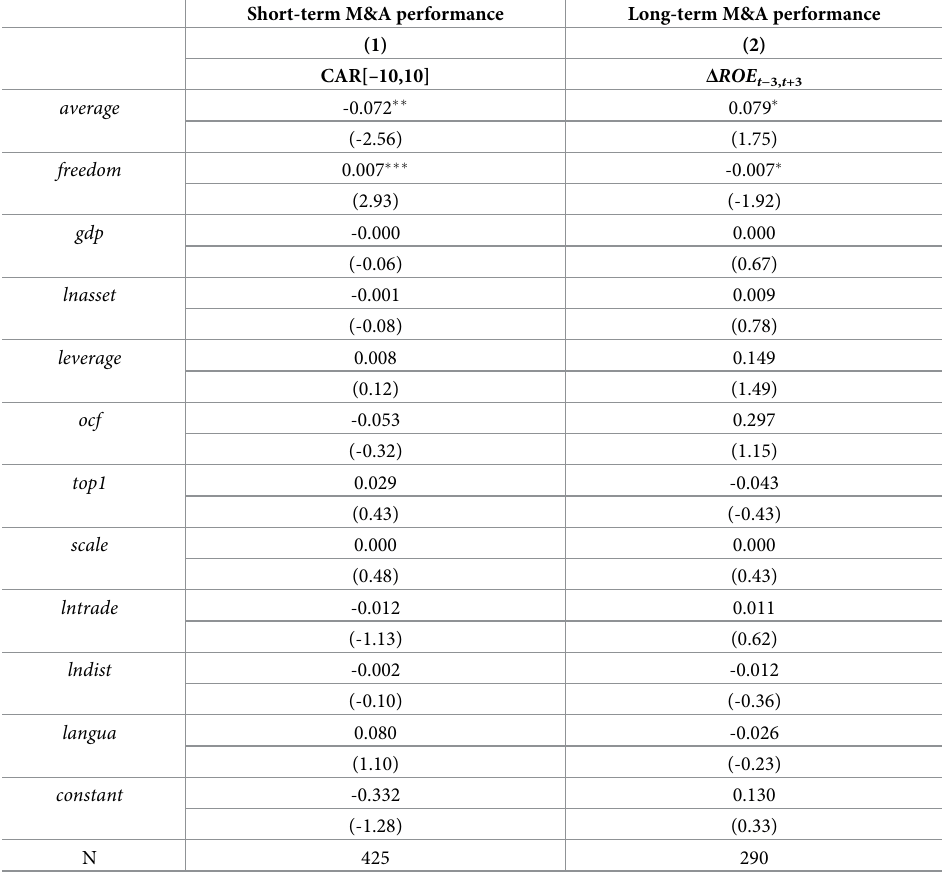
Table 5. Robustness test of governance capacity and short-term and long-term M&A